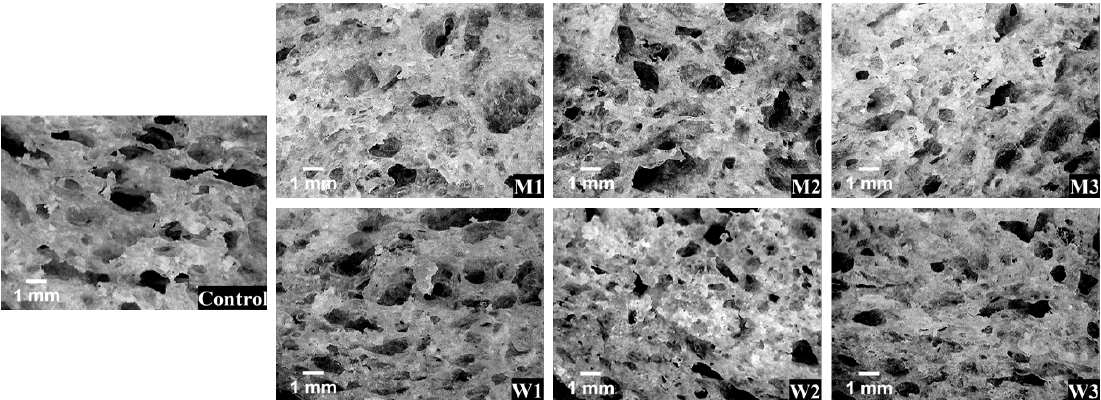
Figure 4. Crumb microstructure of bread samples with di ff erent water replacement levels: M1—12.5% milk,